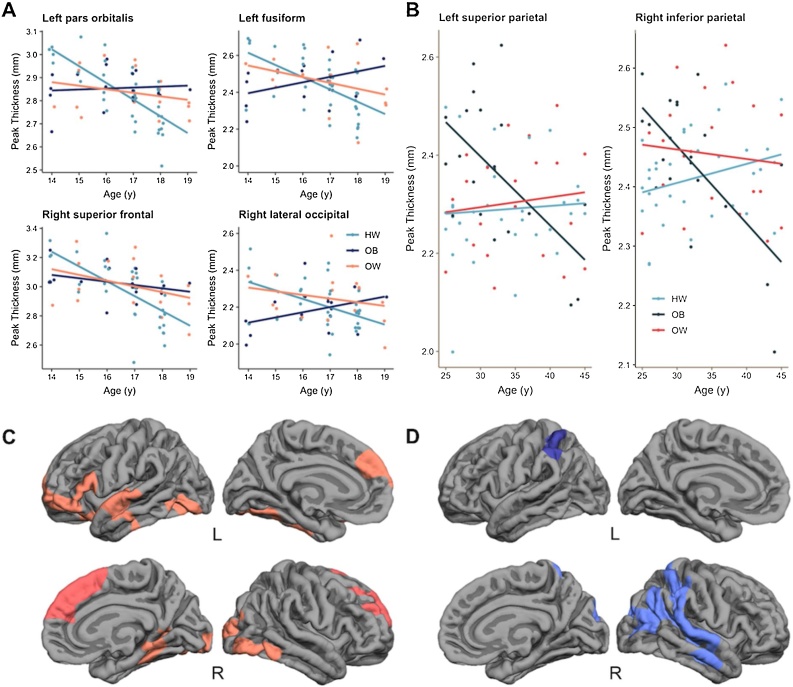
Combined effects of age and adiposity relate to altered local cortical thickness in adolescents and adults.A & C) In adolescents, increased BMI Z-score and age related to greater CT in the left orbitofrontal cortex, left fusiform area, right superior frontal gyrus and right lateral occipital cortex. B & D) A significant age-by-BMI interaction was associated with reduced bilateral parietal CT in mid-adulthood. All scatterplots show peak CT values of significant clusters (Monte Carlo Null-Z simulation corrected p < .05). To improve visualisation, the continuous age by BMI measure interaction has been plotted by weight group.